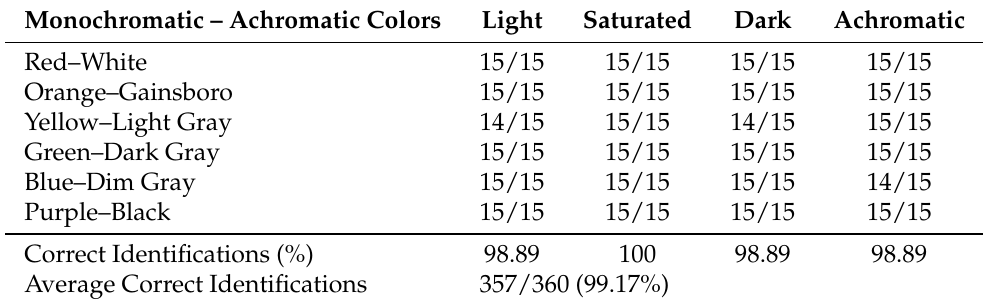
Table 3. The correct identifications out of total color identifications made by fifteen subjects for ColorWatch color